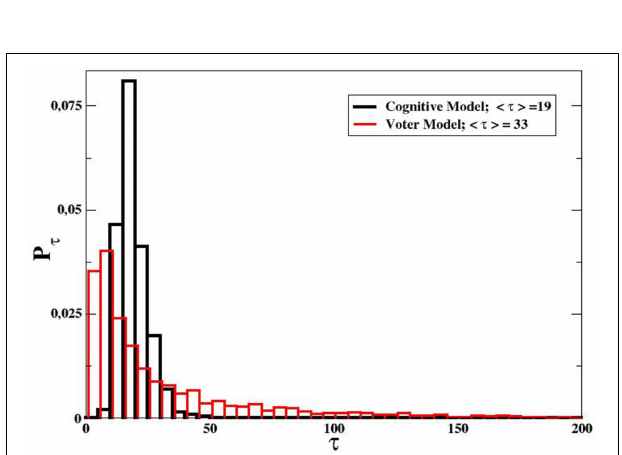
FIGURE 8 | Probability distribution of the time needed to reach consensus τ for the cognitive opinion model (black) and the voter model (red). Mean-field case, system size N = 100 , initial average opinion h O 0 i = 0 . 5